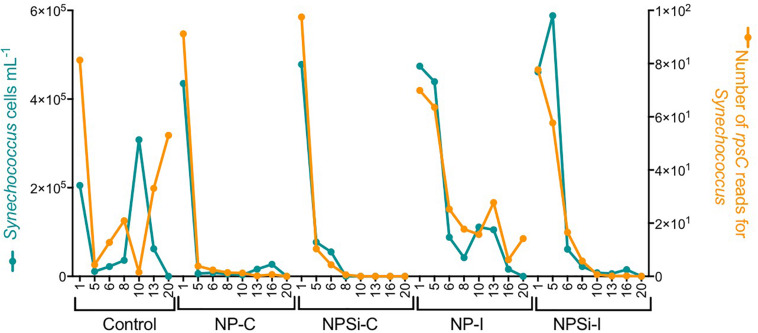
Relationship between the cell abundance measured using flow cytometry and the number of rpsC reads for Synechococcus, determined during our experiment and broken down for each treatment and day.